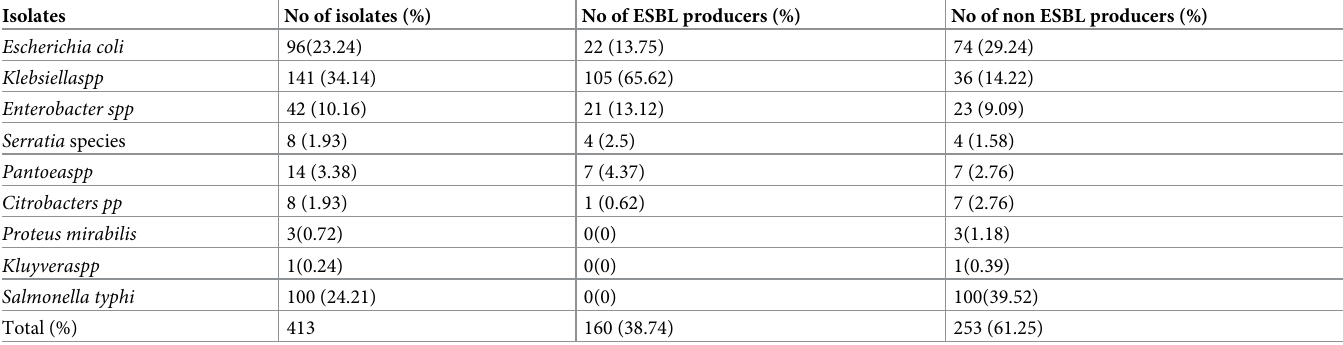
Table 1. Frequency of ESBL and Non ESBL producing isolates from blood culture.